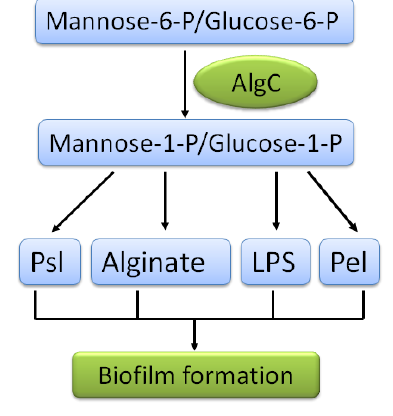
Figure 4. Diagram of AlgC-dependent enzymatic regulation of the production of exopolysaccharides in P. aeruginosa PAO1 [116]. The product of algC gene (AlgC) is a bifunctional enzyme with phosphomannomutase (PMM) and phosphoglucomutase (PMG) activities that can catalyze the conversion of mannose-6-phosphate (mannose-6-P) and glucose-6-phosphate (glucose-6-P) into mannose-1-phosphate (mannos-1-P) and glucose-1-phosphate (glucose-1-P), respectively. The PMM/PMG activity of AlgC is required for the biosynthesis pathways of four exopolysaccharides (Psl, alginate, LPS and Pel) in P. aeruginosa . Experimental data showed that overproduction of individual exopolysaccharides reduces synthesis of the other exopolysaccharides, indicating that AlgC is the checkpoint enzyme that limits the production of P. aeruginosa exopolysaccharides, influencing the biofilm